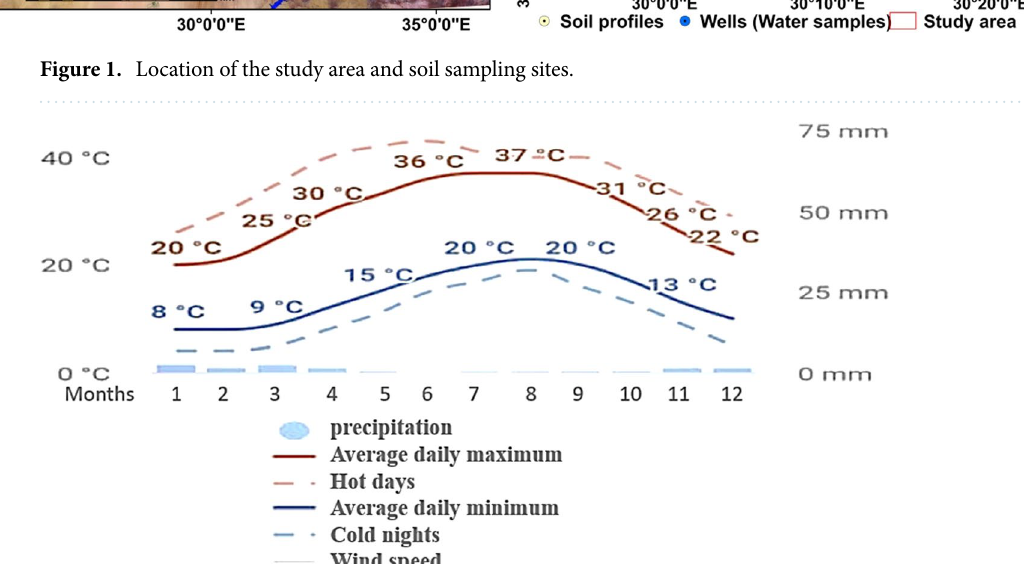
Figure 2. The monthly temperatures and precipitation of the study area in 2019. [Collected from Wadi El Natrun station from (1986) to (2016)].